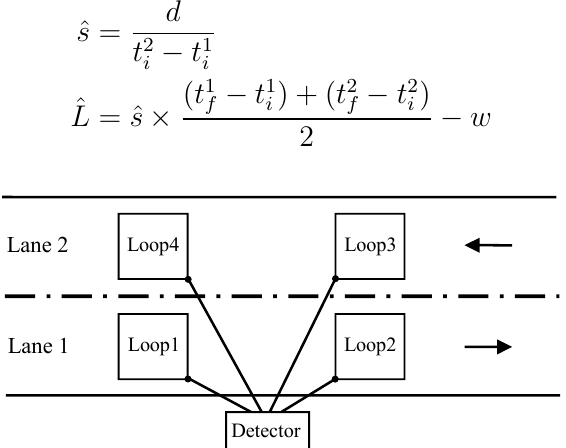
Figure 1. Interconnections from the inductive loop to the